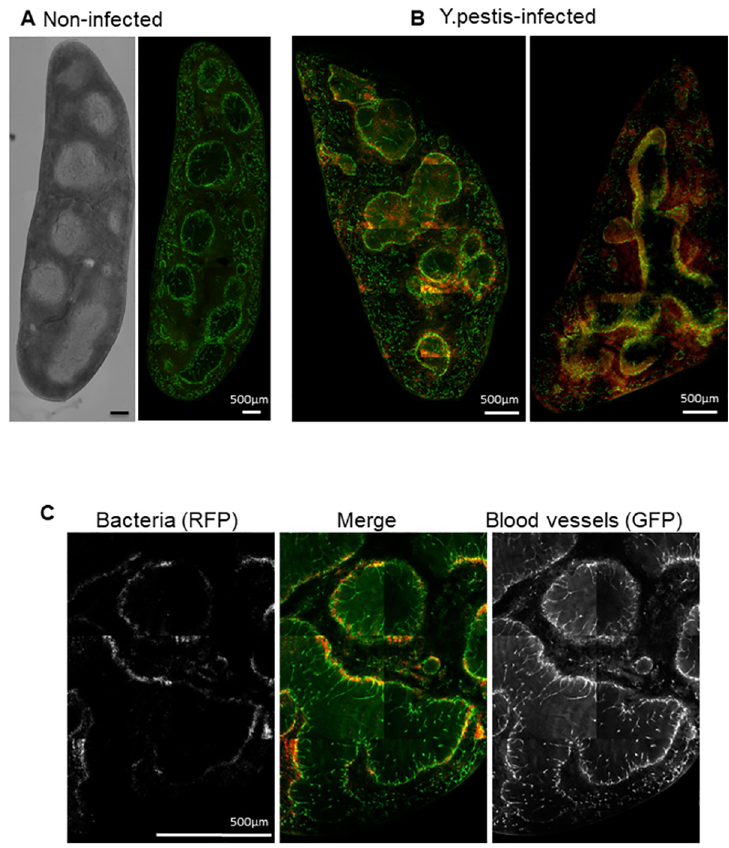
Fig 2. Confocal microscopy observation of blood vessels in the spleen of non-infected and Y . pestis -infected Flk1-GFP mice. For all images, the red color corresponds to bacteria and the blood vasculature is colored in green. A. Non-infected Flk1-GFP mouse spleen. Left, white field picture showing the visual structure of the spleen with white pulp appearing clear grey and red pulp appearing darker. Right, organization of blood vasculature in the red pulp and around the white pulp. B. Spleen from two Y . pestis -infected Flk1-GFP mice on D3 post-infection. Clear presence of red Y . pestis bacteria in blood vasculature, particularly around the white pulp. On the left panel blood vessels around white pulp appear strongly disorganized and partially disrupted. C. Y . pestis -infected mouse on D3 post-infection. Bacteria (left panel) and blood vessels (right panel) are merged in the middle panel where bacteria fluoresce in red and blood vessels in green. Images are reconstructed from panels each corresponding to the maximum of intensity (MIP) calculated on 200 μ m thick sections (A: 10 panels (2x5); B left: 24 panels (4x6); B right: 18 panels (3x6); C: 6 panels (2x3) calculated on 150 μ m thick sections). Bar = 500 μ